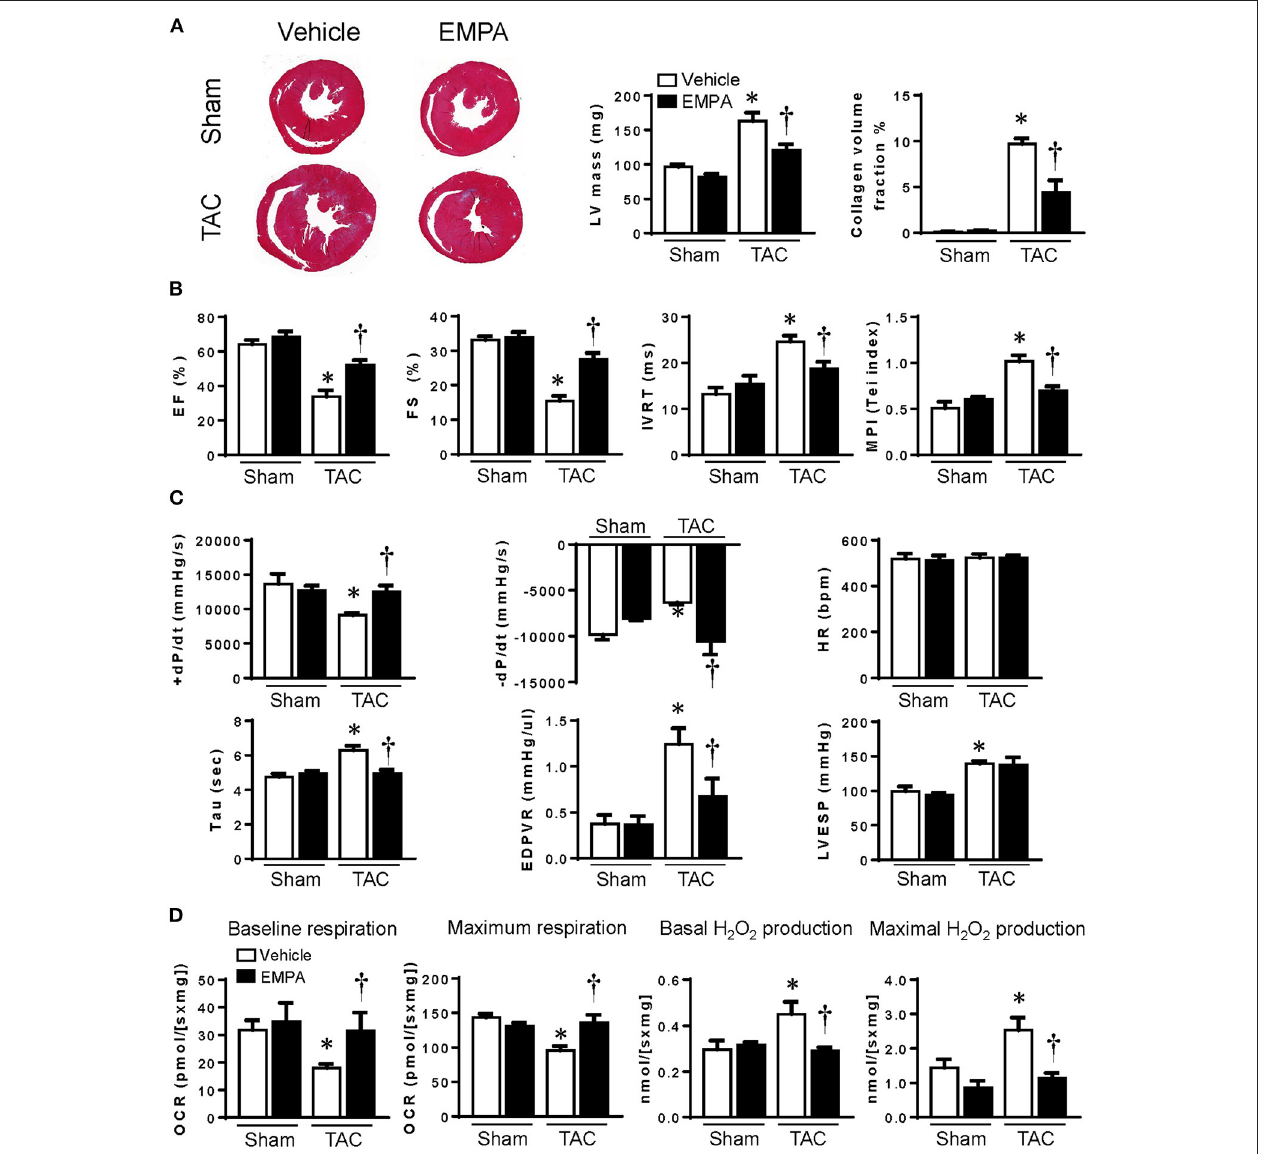
FIGURE 1 | EMPA treatment attenuated remodeling of the LV, improved cardiac function and increased mitochondrial respiration. (A) Left, Masson staining of cross sections of hearts and Right (the collagen fibers were stained blue), quantitative analysis of left ventricle (LV) mass and heart collagen volume. (B) Transthoracic echocardiography showed the ejection fraction (EF), fraction shortening (FS), isovolumetric relaxation time (IVRT) and myocardial performance index (MPI) of hearts from different groups. (C) Cardiac function assessed by direct intraventricular pressure measurements. (D) Mitochondrial respiration and peroxide production in hearts from different groups. Original magnification × 100, Results are expressed as mean ± SEM, n = 5–7, * p < 0.05 vs. corresponding sham group, † p < 0.05 vs. corresponding TAC vehicle group. One-way ANOVA and Tukey post hoc test. EMPA, empagliflozin; SEM, standard error of the mean; TAC, transverse aortic constriction; LV, left ventricle; HR, heart rate; EDPVR, end diastolic pressure volume relationship; LVESP, left ventricular end-systolic pressure; OCR, oxygen consumption